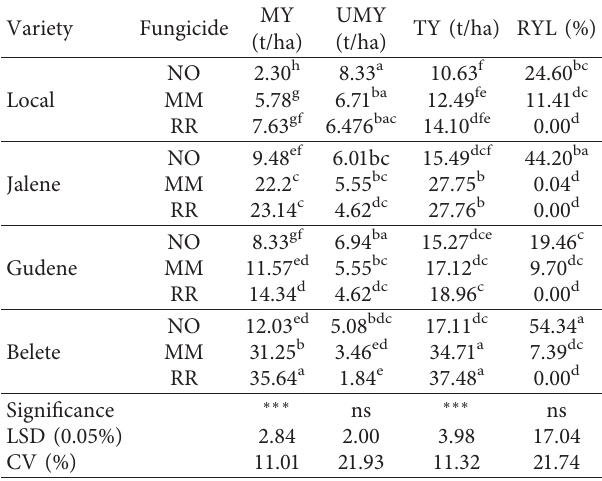
Table 6: Interaction effects of fungicide and potato variety on relative yield loss of late blight potato